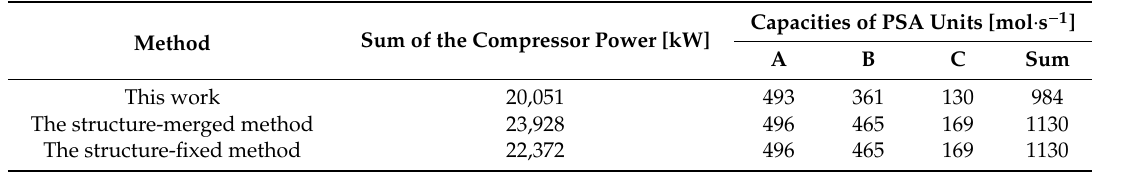
Table 10. Comparison of the device capacity of the three